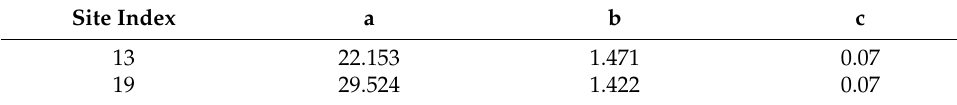
Table A1. Regression parameters for a, b, and c under each site index. Site